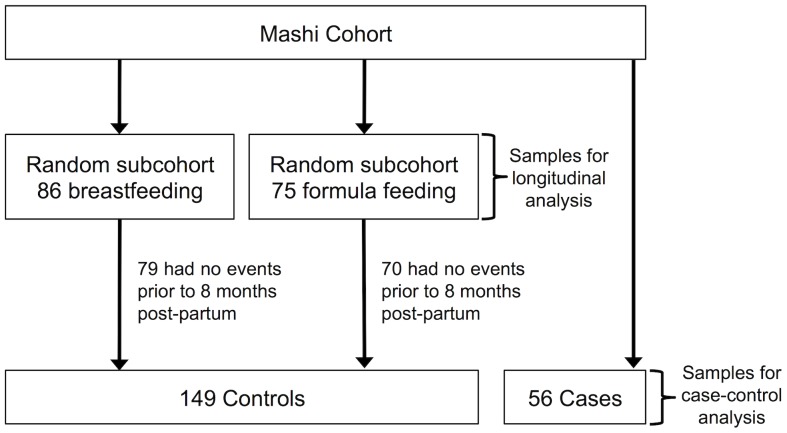
Selection of subcohorts.For Aim 1, we selected at random 86 women from the breastfeeding and 75 women from the formula-feeding arms of the Mashi Study. For Aim 2, a case was defined as a woman who had a six-month postpartum sample available, and experienced a major adverse clinical event after, but not before, eight months postpartum. Women randomly selected for Aim 1 who did not experience any adverse clinical events comprised the controls for Aim 2.